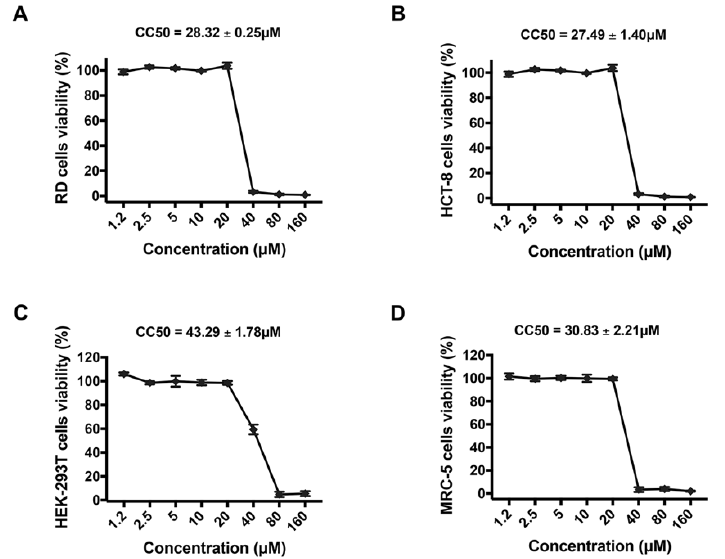
Figure 3. Toxicity for montelukast to different cells. ( A ) RD, ( B ) HCT-8, ( C ) HEK-293T, and ( D ) MRC-5 cells were treated with montelukast at different concentrations, and then cells’ viability was detected by Cell Counting Kit-8 (CCK-8). Data are represented as means ± SD.